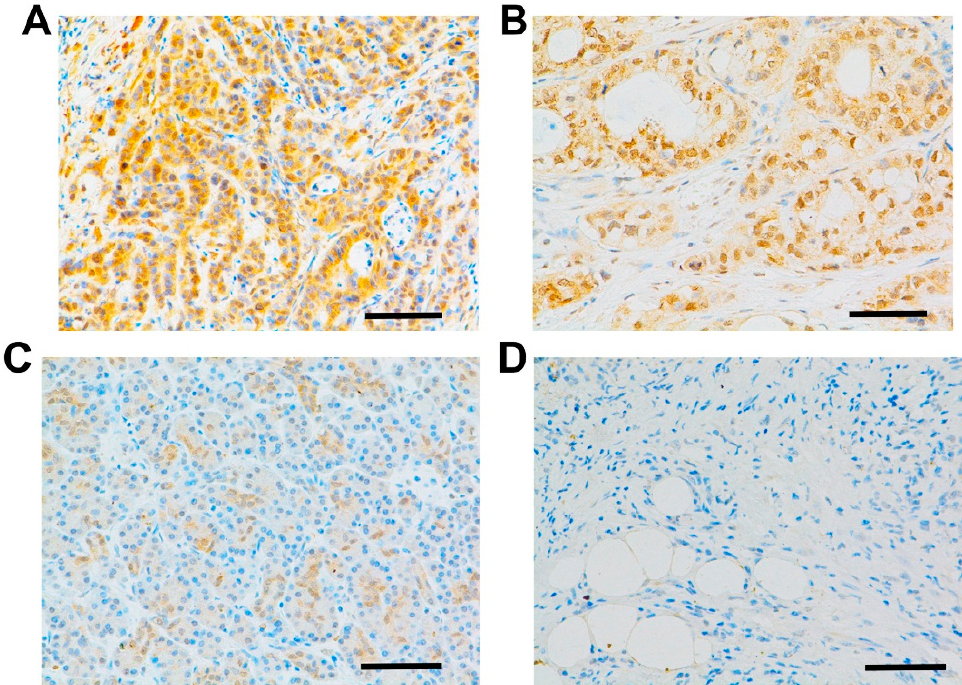
Figure 1. Immunohistochemical analysis of EGFR (epidermal growth factor receptor) in PDAC (pancreatic duct adenocarcinoma)tissues. In PDAC tissues, immunoreactivity for EGFR was observed on the surface and in the cytoplasm of cancer cells ( A – C ), with no immunoreactivity in the surrounding stroma ( D ). The immunoreactivity was different in respective cases: ( A ) strong; ( B ) moderate; ( C ) weak expression; and ( D ) absent (scale bars, 200 μ m).